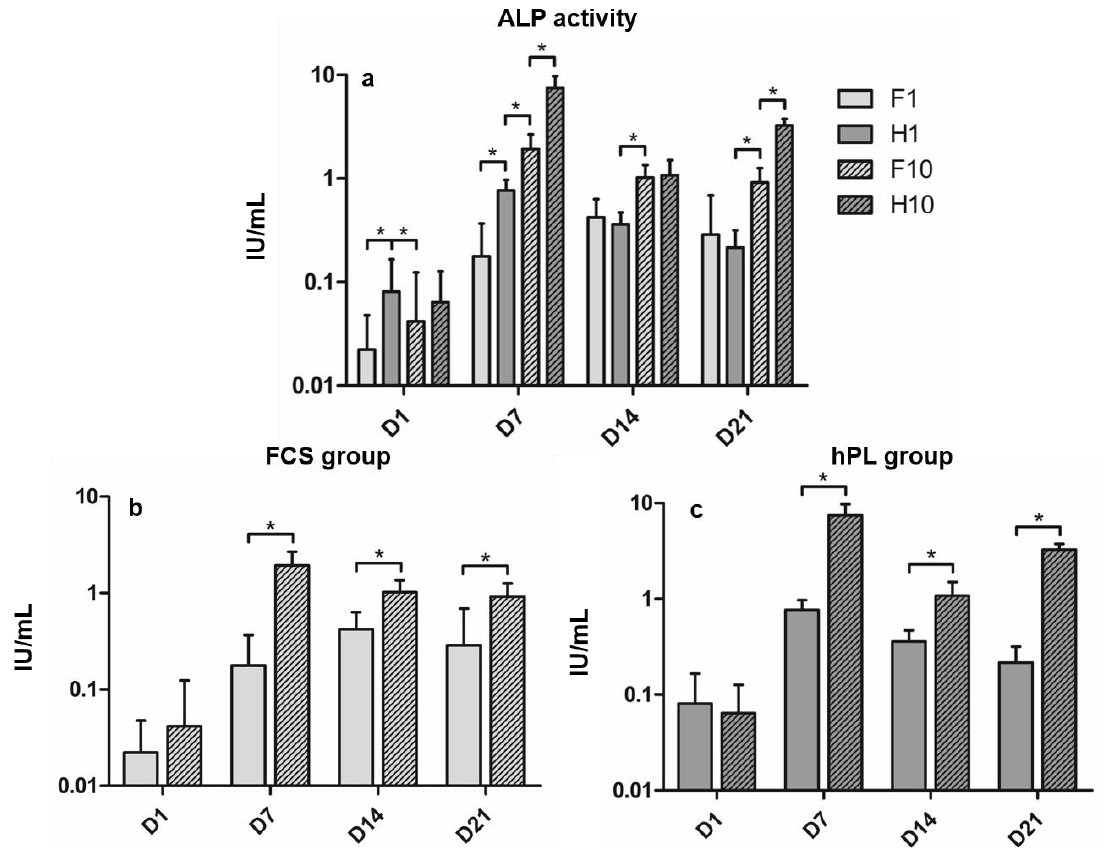
Figure 2. ( a ) Alkaline phosphatase activity during time of incubation in ODM in IU / mL of all groups. ( b ) ALP activity of FCS groups. ( c ) ALP activity of hPL groups. Values are shown as means with SD. * mark significant differences. D = day.